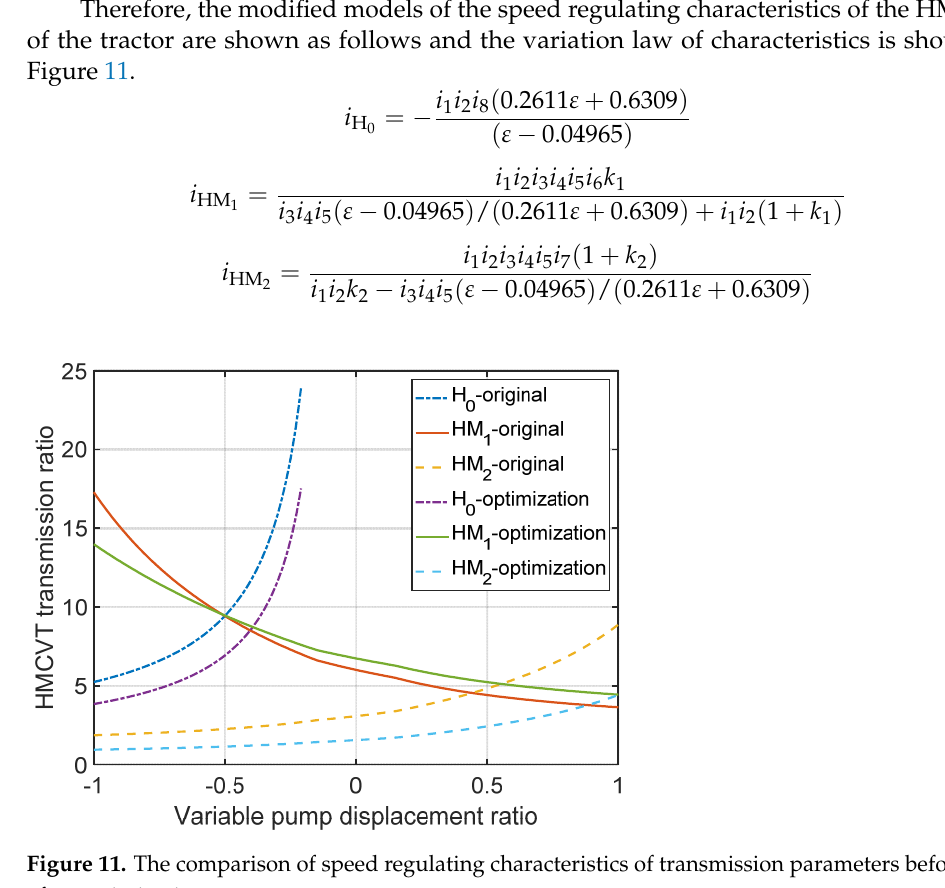
Figure 12. I-PSO-based iteration evolution curve. After the optimization, (